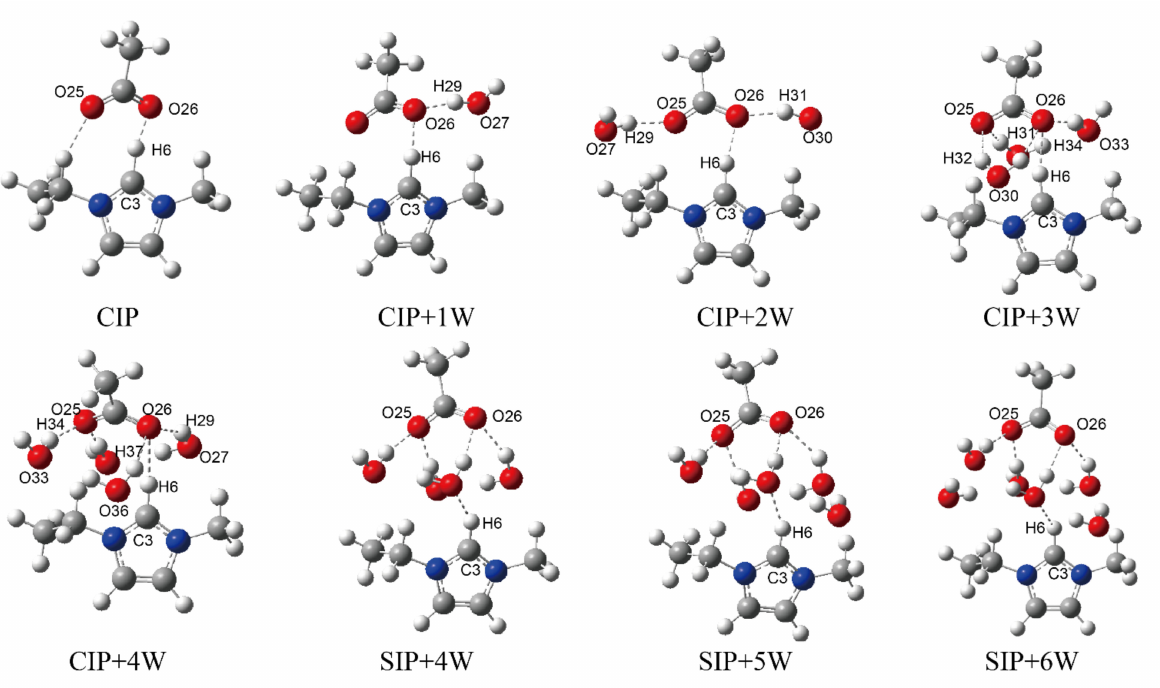
Figure 7. Density functional calculated structures of the solvent-separated ion pairs (SIPs) and contact ion pairs (CIPs) for EmimOAc- n H 2 O ( n = 0–6)